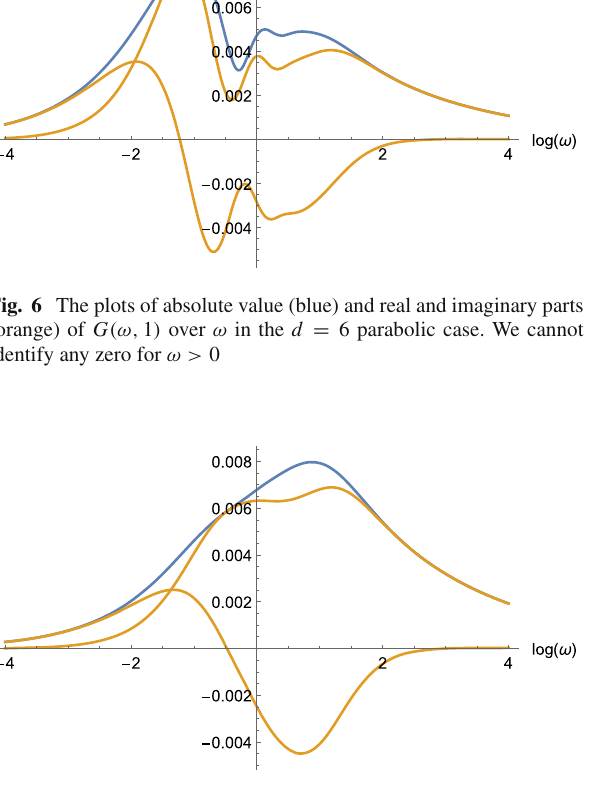
Fig. 7 The plots of absolute value (blue) and real and imaginary parts (orange) of G (ω, 1 ) over ω in the d = 7 parabolic case. Again, we cannot identify any zero for ω > 0